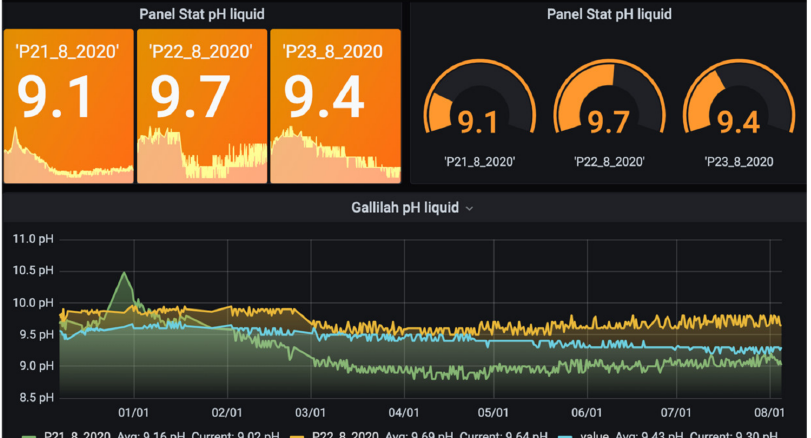
Figure 15. Graphana dashboard for real-time data visualization: pH concentration in the monitored concrete abutment.